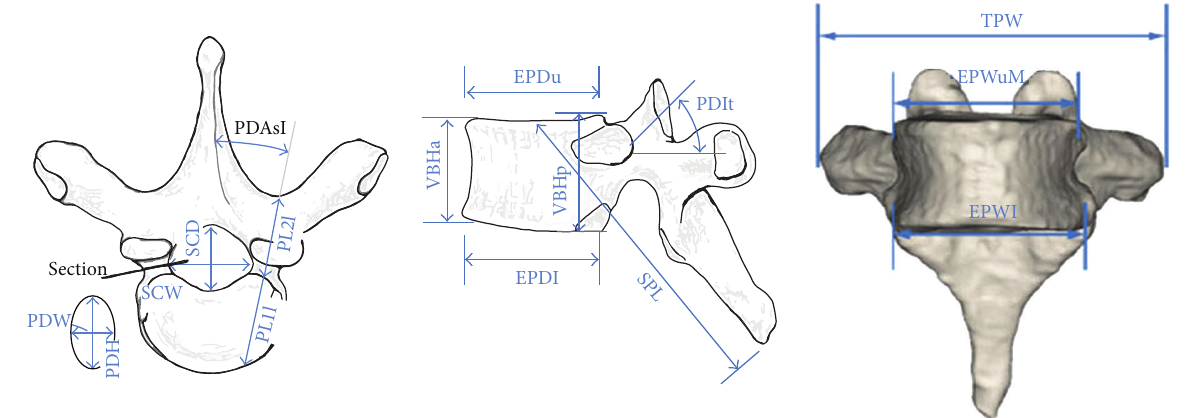
Figure 4: Geometry data related to cervical vertebras.